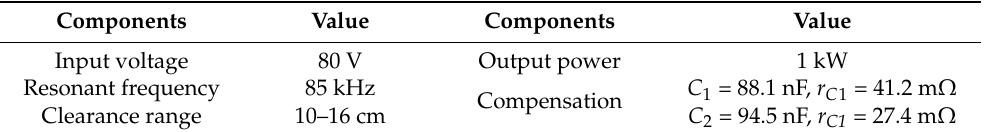
Figure 11. Photo of the prototype. Table 2. IPT prototype parameters.